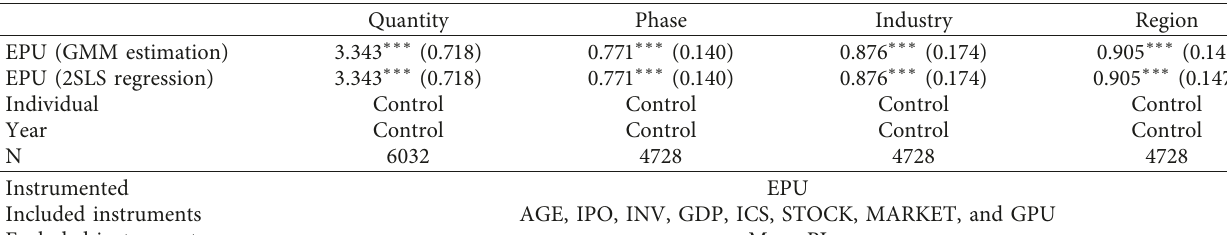
Table 8: Robustness test for the two-step GMM